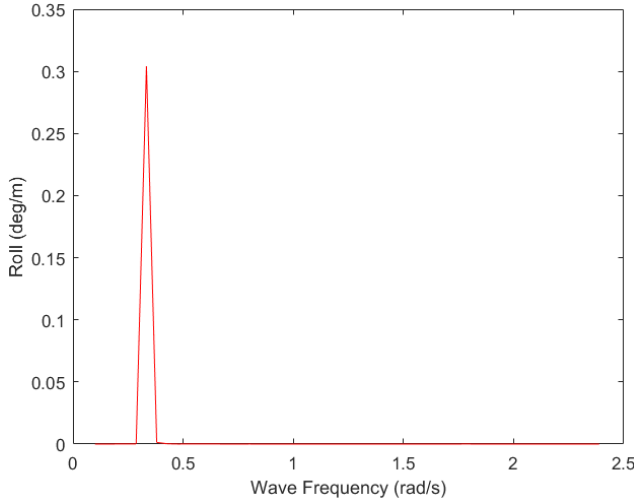
Figure 21. The frequency response of the roll motion of the platform.